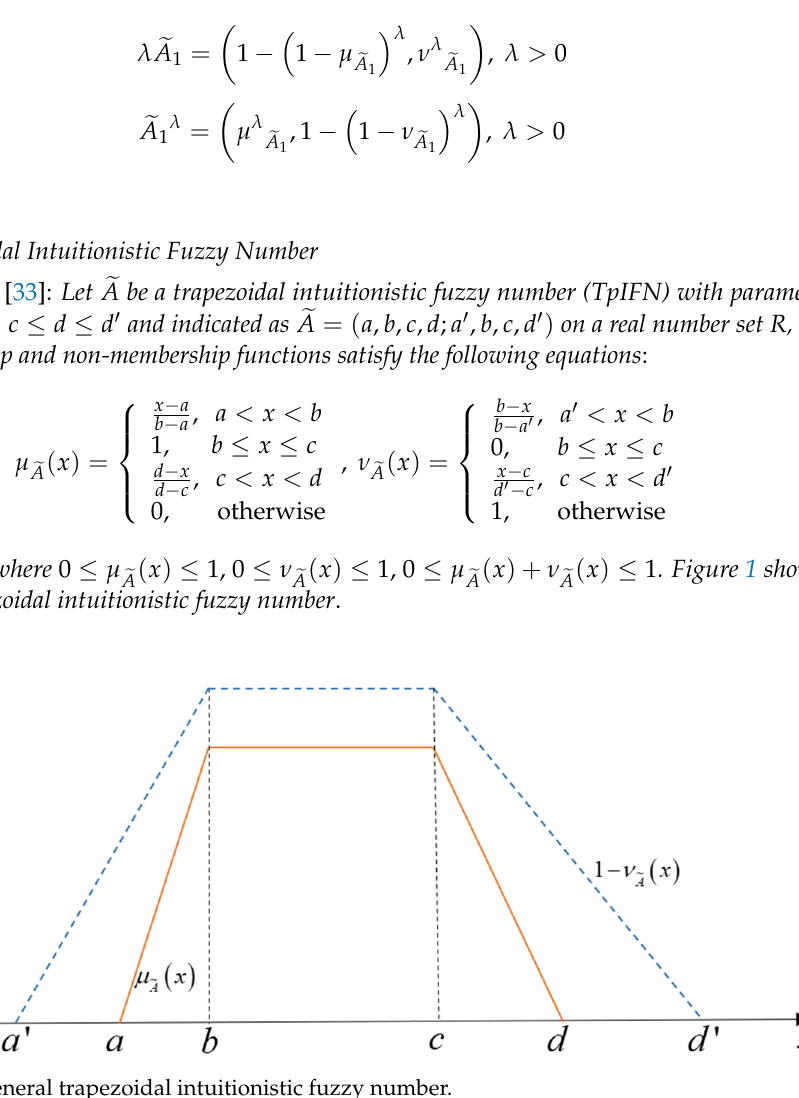
Figure 1. A general trapezoidal intuitionistic fuzzy number.